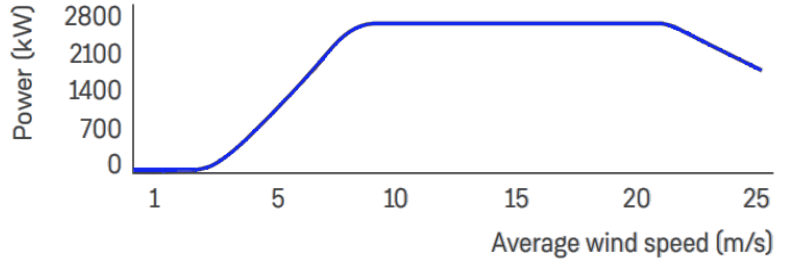
Figure 3. Power curve of SG 2.6-114 wint turbine (WT) model [34].